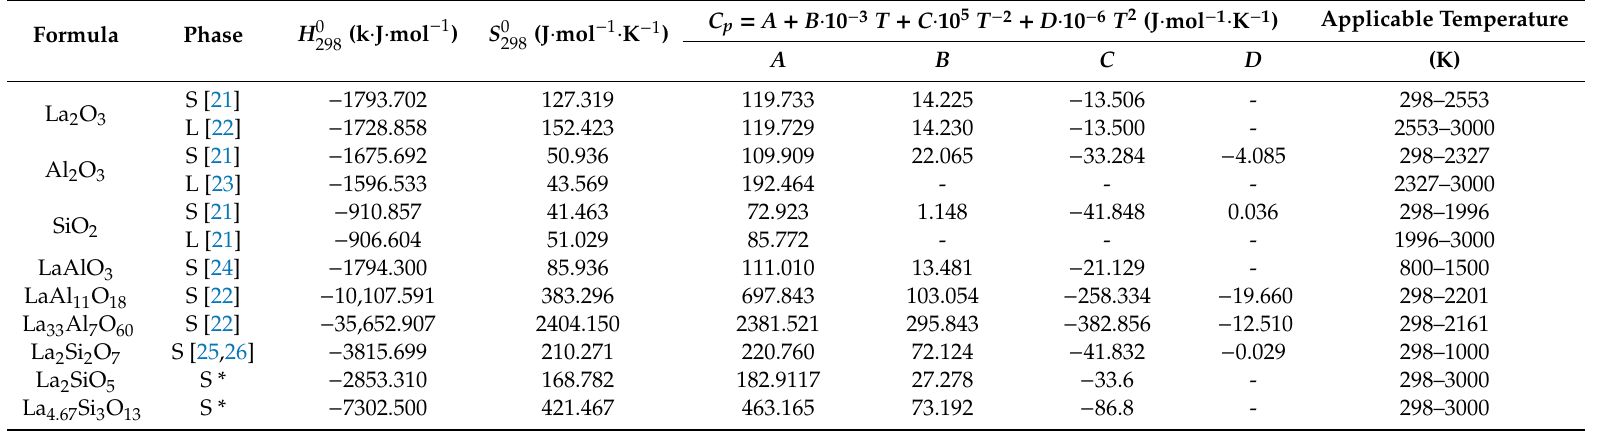
Table 1. Thermodynamic properties of pure